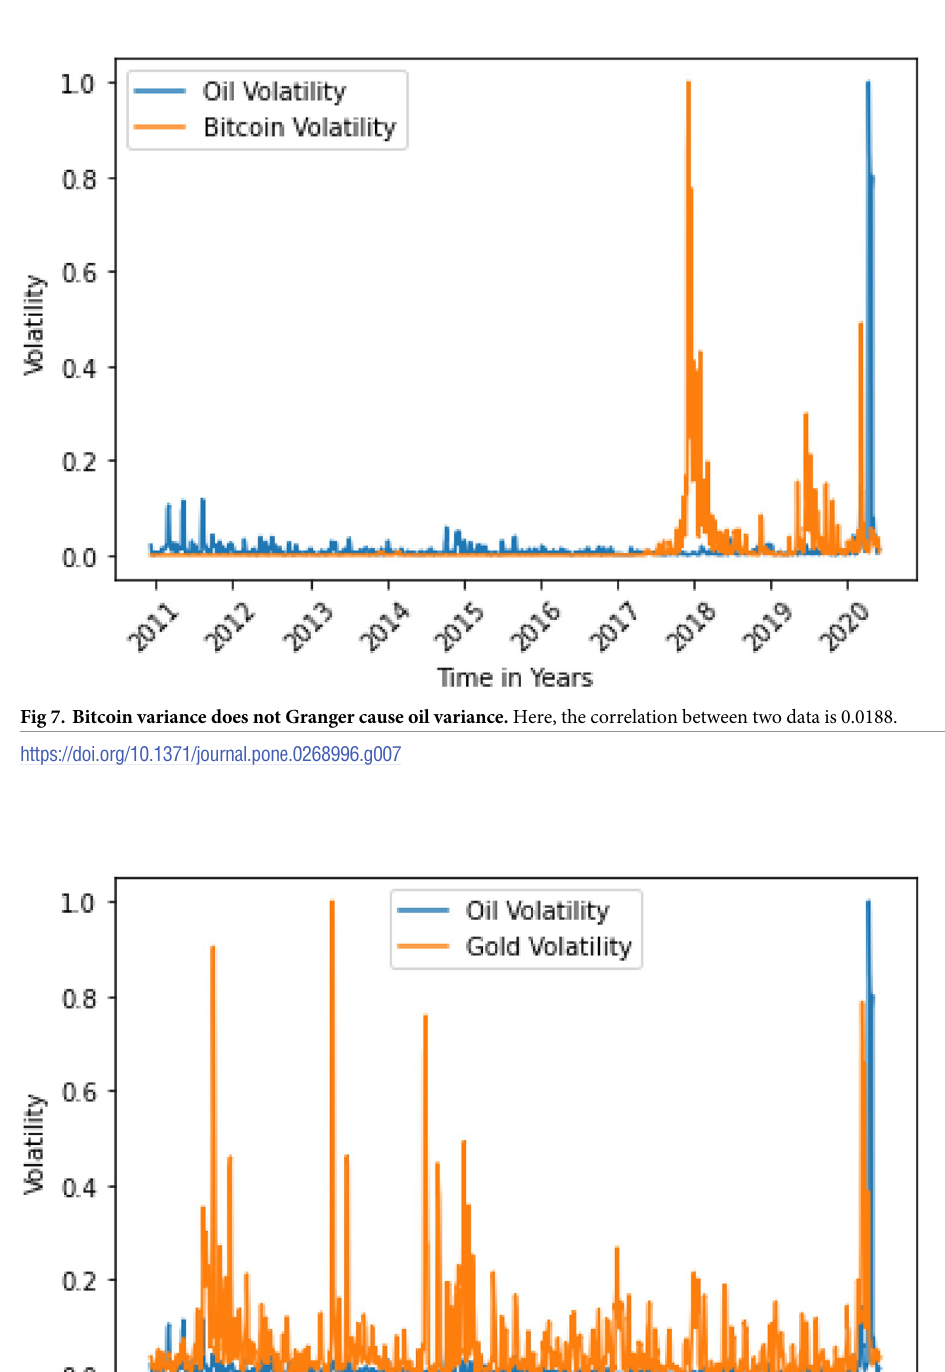
PLOS ONE | https://doi.org/10.1371/journal.pone.0268996 March 9,